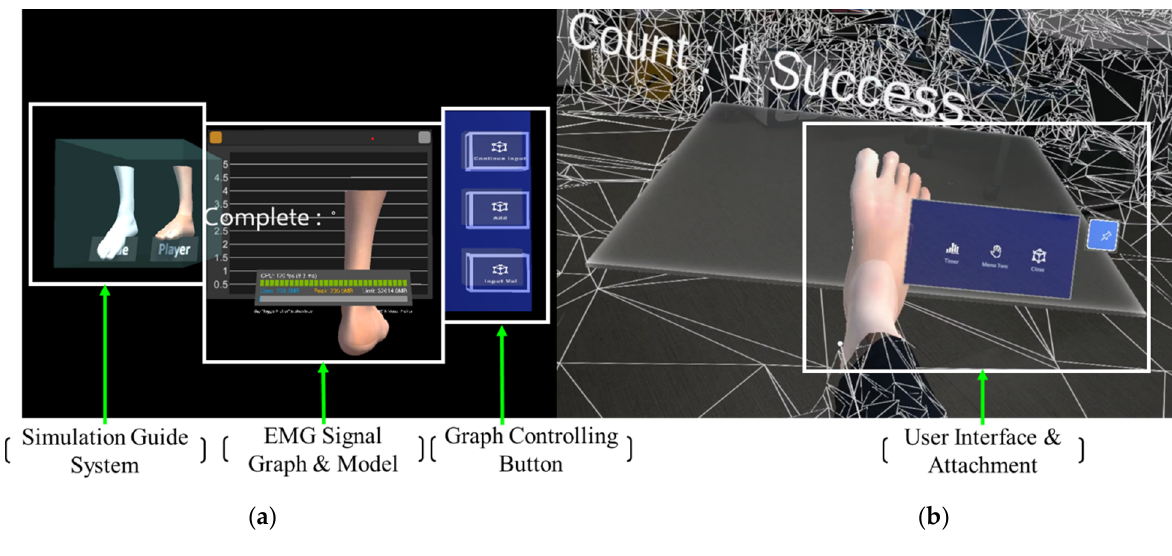
Figure 8. Composition and Actual Operation of XR System (( a ) = Full Screen of Simulation Program Component, ( b ) = Actual Operating Figure).